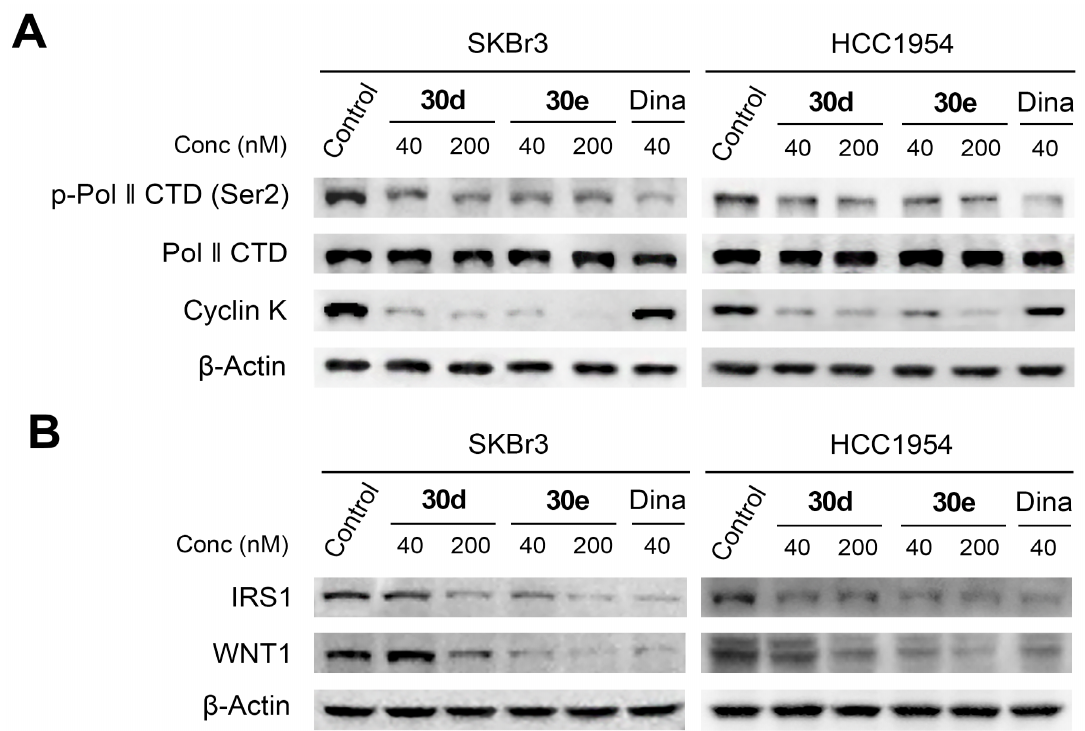
Figure 7. Both 30d and 30e showed a potent, dose-dependent downregulation of ( A ) cyclinK and p-Pol II CTD (Ser2), and ( B ) the expressions of CDK12 downstream genes (IRS1 and WNT1) in SK-Br3 and HCC1954 cells. Compounds were treated at 40 and 200 nM for ( A ) 2 h or ( B ) 24 h; then, Western blot analysis was performed. Control = DMSO, Dina = dinaciclib.